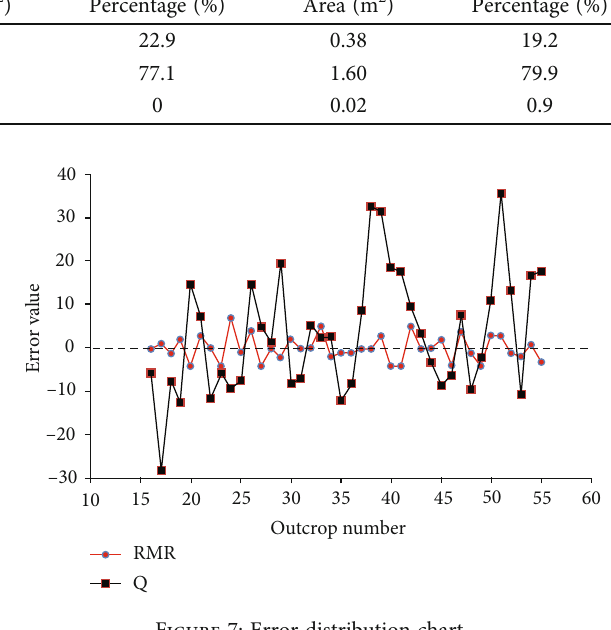
Figure 7: Error distribution